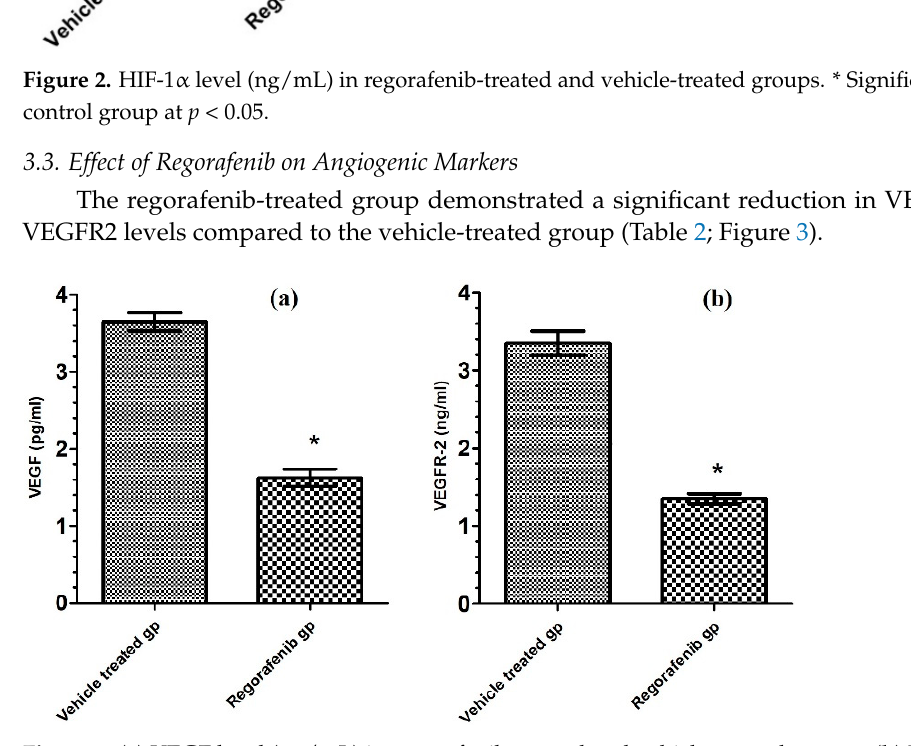
Figure 3. ( a ) VEGF level (pg/mL) in regorafenib-treated and vehicle-treated groups; ( b ) VEGFR-2 level (ng/mL) in regorafenib-treated and vehicle-treated groups. * Significant from control group at p < 0.05.